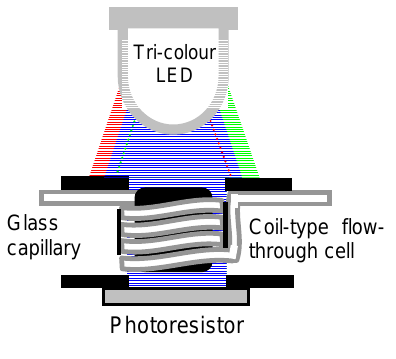
Figure 1 . Optical geometry of the tri-colour LED-based spectrometer.